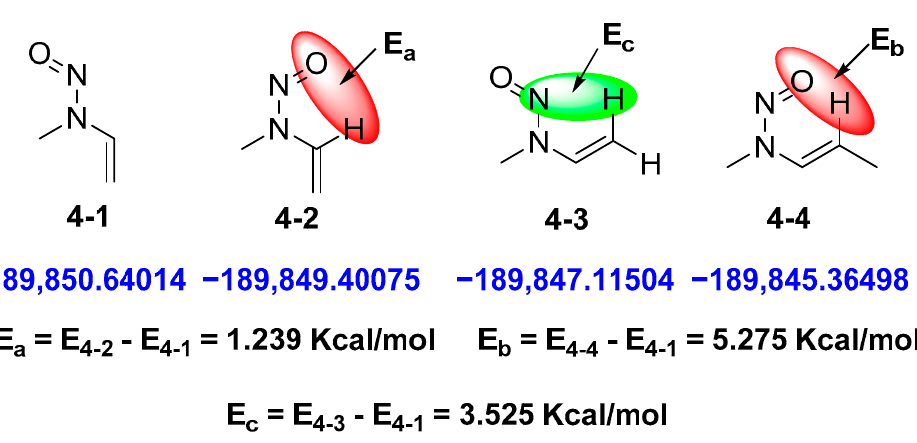
Figure 4. The Gibbs free energies and energy differences of four possible conformers for compound 4 .